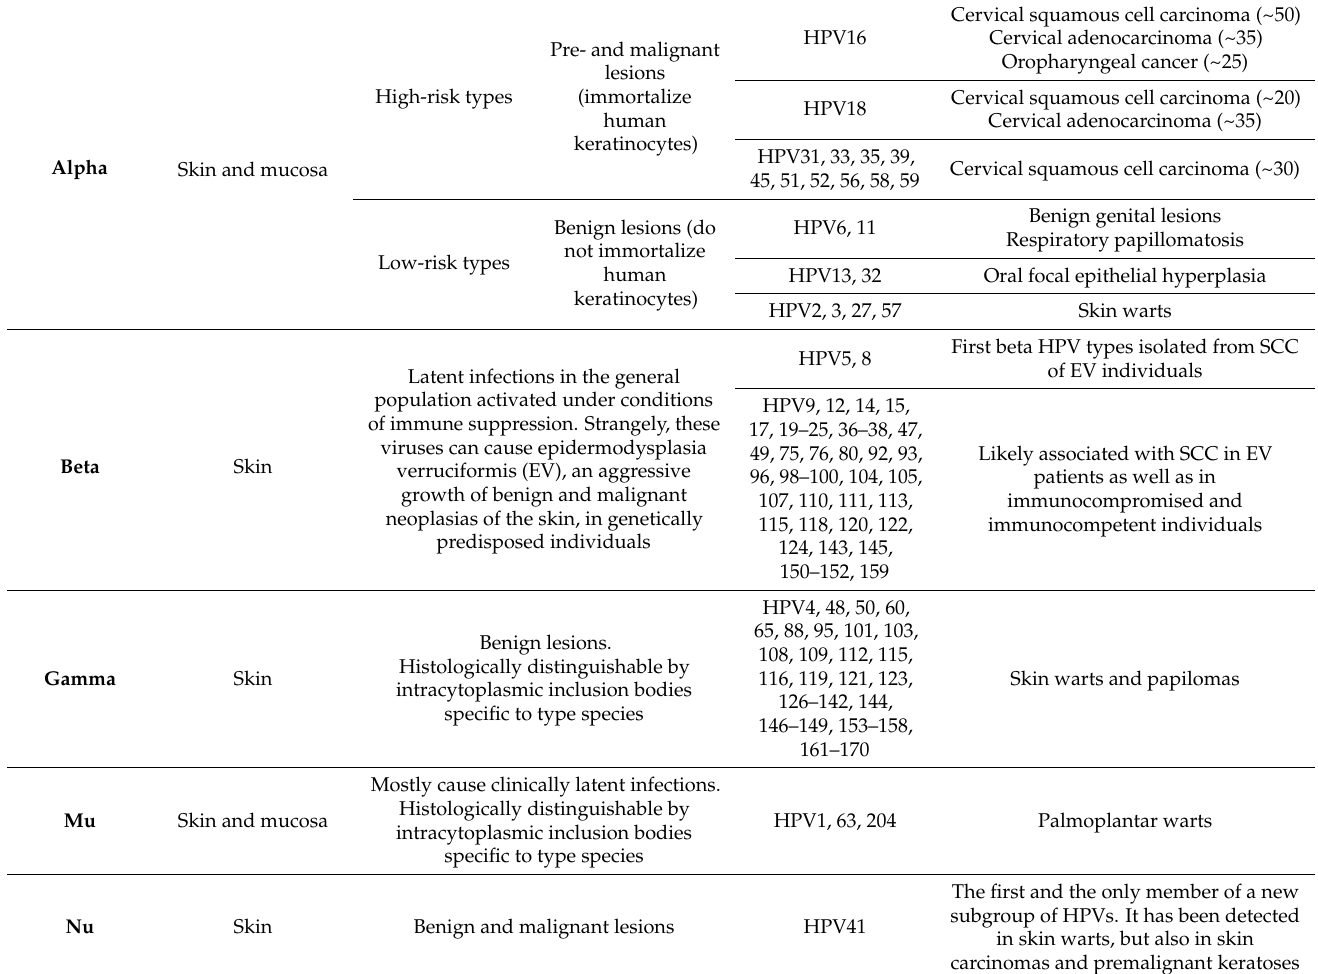
Table 1. Major known HPV